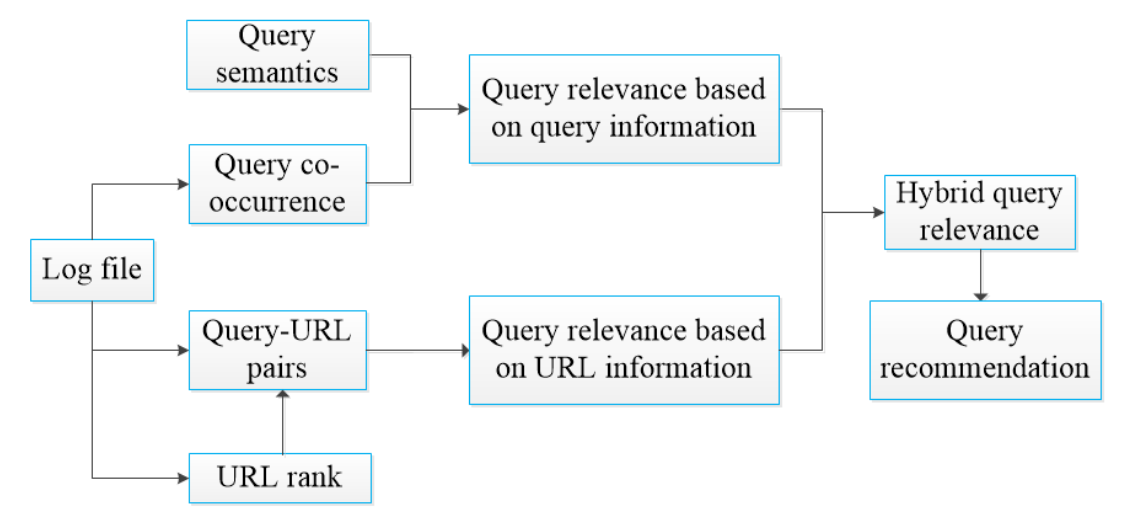
Figure 1. Architecture showing query